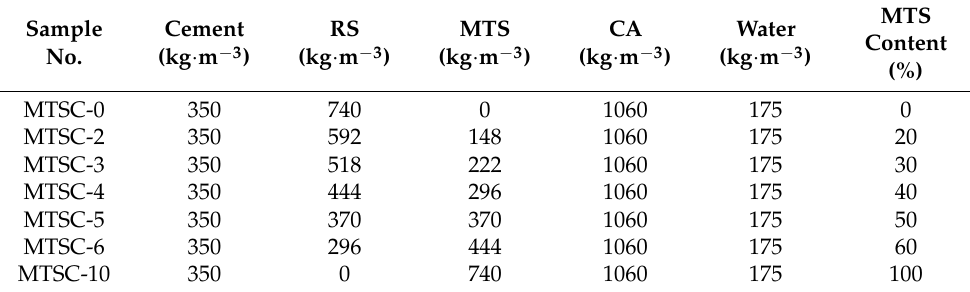
Table 4. Mix proportions of